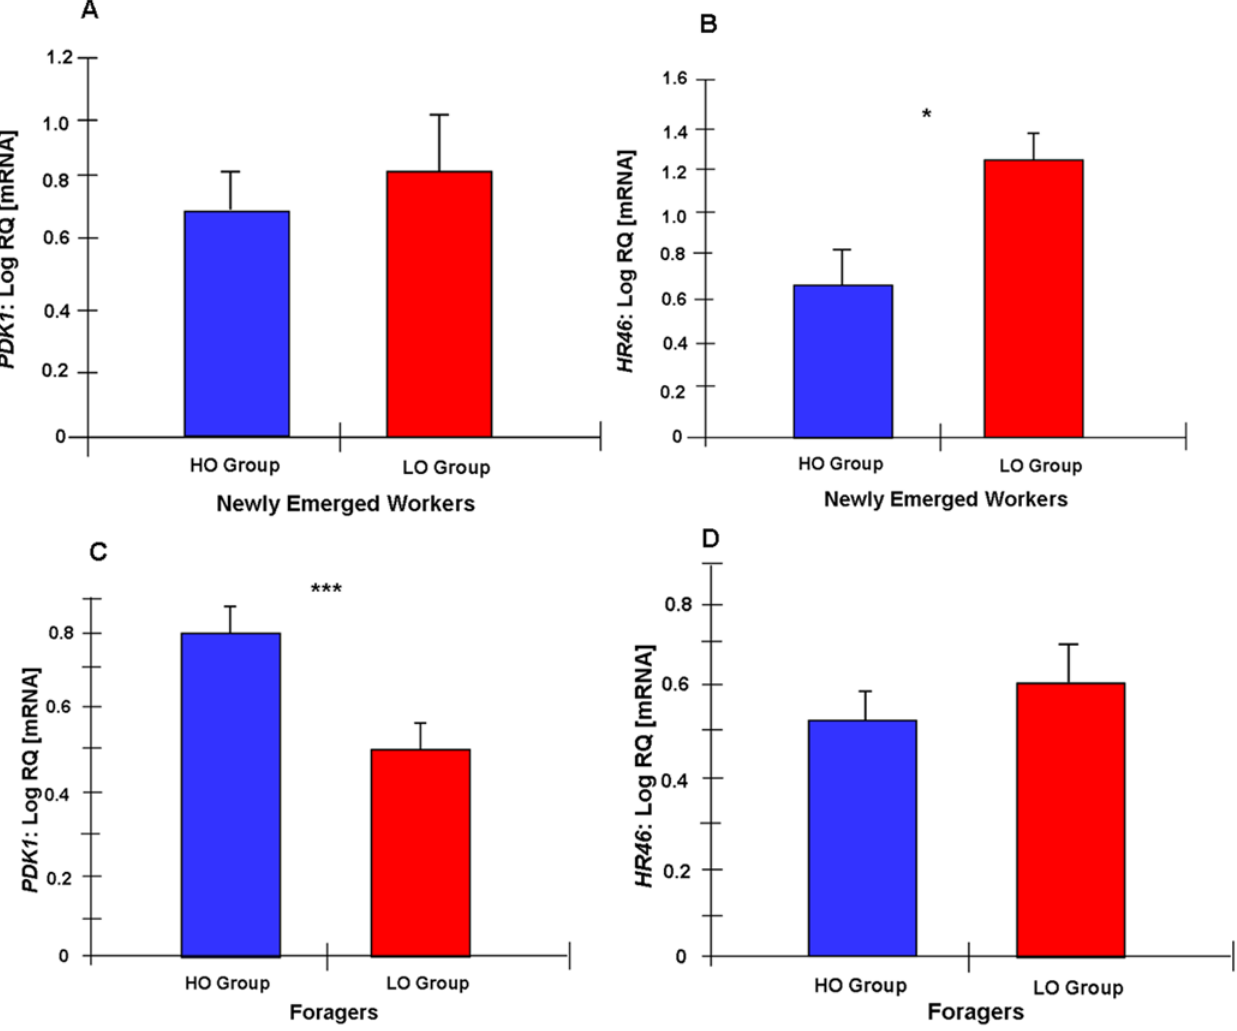
Figure 4. Associations between gene expression, ovary size, and behavior. Log transformed mRNA levels (mean 6 s.e.m., relative quantities, n=24) of candidate genes in the abdominal fat body of newly emerged workers and foragers derived from a backcross of high and low pollen- hoarding strain bees. Workers are divided into groups with extremely low (LO) or high (HO) ovariole numbers. A: PDK1 shows no significant difference between groups of newly emerged bees with different ovariole number. B: HR46 mRNA levels are significantly higher in newly emerged bees with low ovariole number compared to the group with high ovariole number. C: PDK1 gene expression is significantly higher in foragers with high ovariole number compared to the group with low ovariole number. D: HR46 shows no significant difference in the foragers. *, , 0.05; **, , 0.01; ***, ,